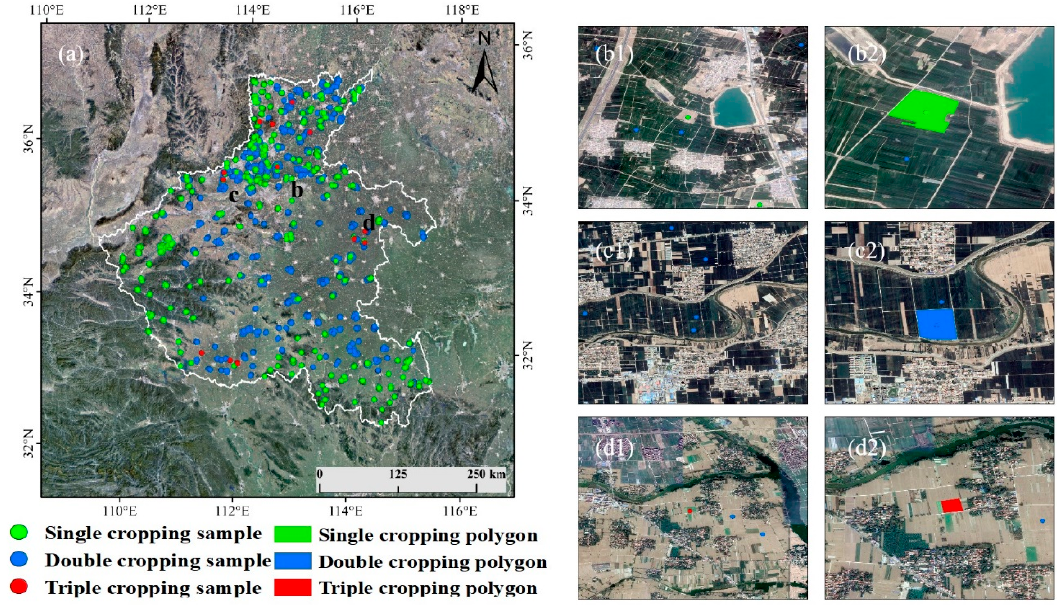
Figure 3. ( a ) is the spatial distribution of sample points. ( b1 — d1 ) are samples of different cropping intensities. ( b2 – d2 ) areas generated by the samples. ( b1 ) and ( b2 ), ( c1 ) and ( c2 ), ( d1 ) and ( d2 ) correspond to b, c, d in ( a ), respectively. Image source: Image 2021 Maxar Technologies and 2021 CNES/Airbus. Image date: Identified in the picture. Color composite: RGB (red, green, blue).